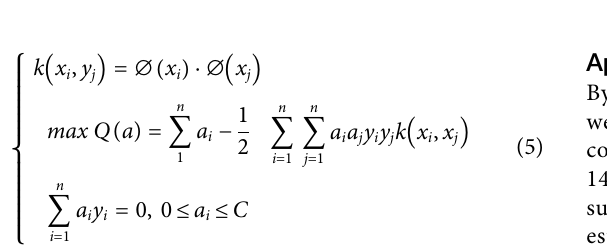
Frontiers in Earth Science |